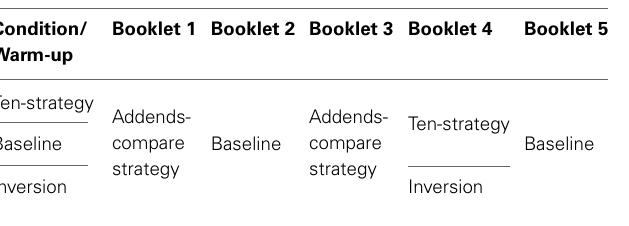
Table 2 | The order of the booklets in Experiment 2.